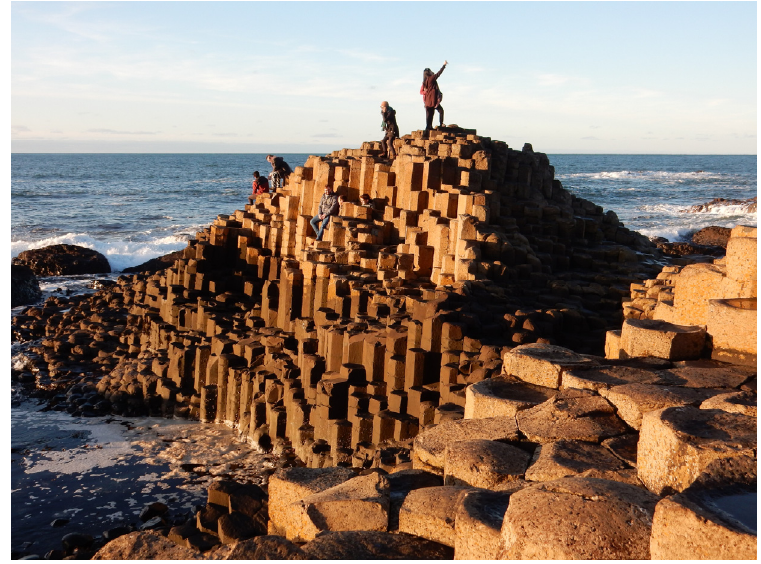
Figure 12. Giant’s Causeway, County Antrim: hexagonal jointing in Palaeogene basalt lavas (Photo: S. Gatley).